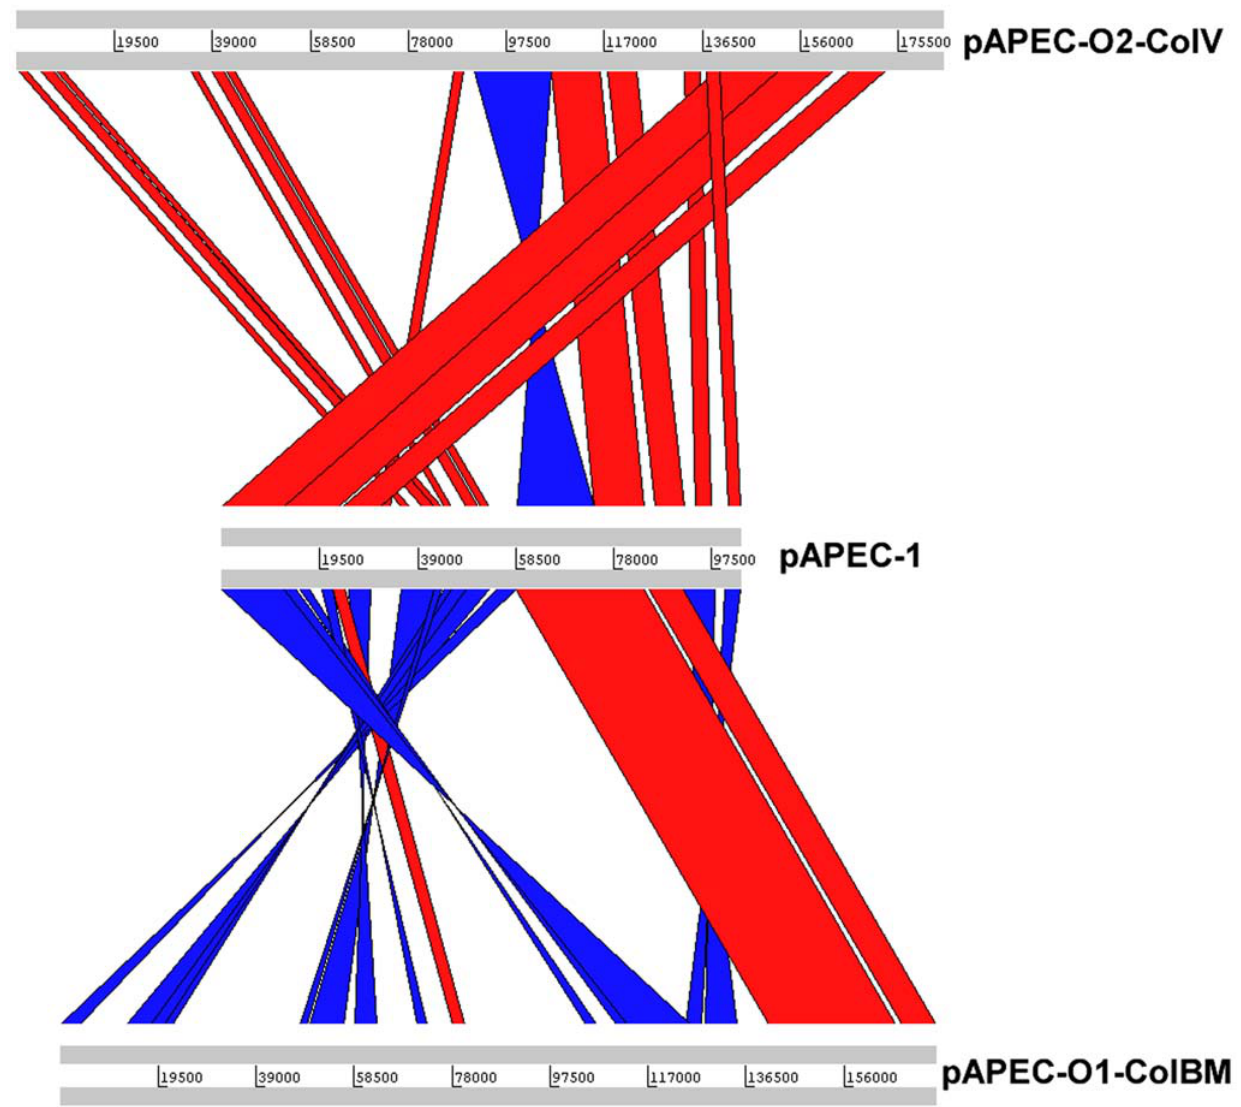
Figure 5. Pairwise nucleotide comparison of the complete pAPEC-1 DNA sequence to that of pAPEC-O1-ColBM (NC_009837) and pAPEC-O2-ColV (NC_007675). Same-strand DNA similarity is shaded red, while reverse similarity is shaded blue. Aligned regions greater than 1000 base pairs with a percent-identity . 96% are shown. Comparisons were generated with the Artemis comparison tool, ACT [84].